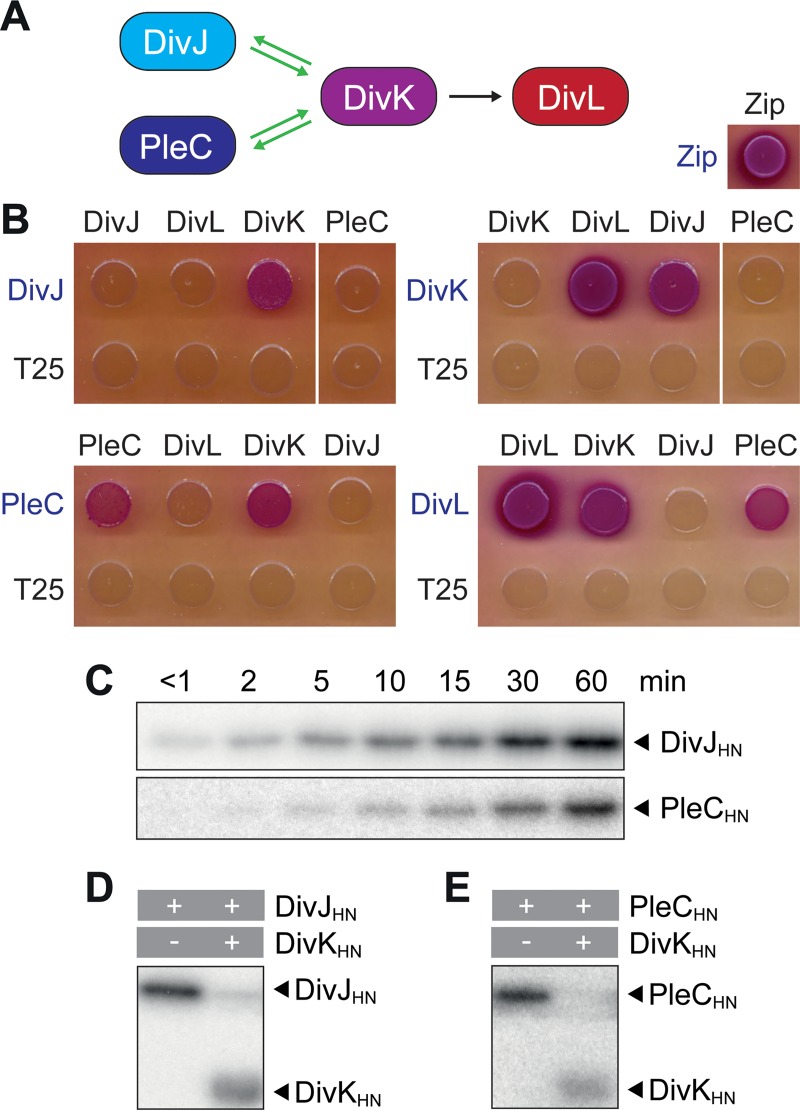
The connectivity within the DivJ/PleC-DivK module is conserved in H. neptunium.(A) Scheme of the interactions within the DivJ/PleC-DivK-DivL module, as demonstrated in this study. Green arrows indicate phosphotransfer. The black arrow indicates a regulatory protein-protein interaction. (B) Bacterial two-hybrid assay testing for interactions between the proteins in the DivJ/PleC-DivK-DivL. The indicated proteins were fused to the T18 (black) or T25 (blue) subunit of adenylate cyclase from Bordetella pertussis, respectively. The fusions were produced in the reporter strain E. coli BTH101, and their interaction was analyzed by spotting of the cells on MacConkey agar. Interactions are indicated by a purple coloration of the colonies. The GCN4 leucin-zipper-region from yeast (Zip) was used as positive control, and empty vectors encoding only the T25 subunit as negative controls. (C) Autophosphorylation of DivJHN and PleCHN upon incubation with [γ32P]-ATP. Samples were taken at the indicated time points and analyzed by SDS-PAGE. Radioactivity was detected by phosphor imaging. (D) and (E)
In vitro phosphotransfer from (D) DivJHN and (E) PleCHN to DivKHN. After autophosphorylation of DivJHN for 30 min and of PleCHN for 45 min, the indicated proteins (marked with pluses) were incubated for 90 sec. After addition of SDS sample buffer to stop the reactions, the mixtures were separated by SDS-PAGE, and radioactivity was detected by phosphor imaging.